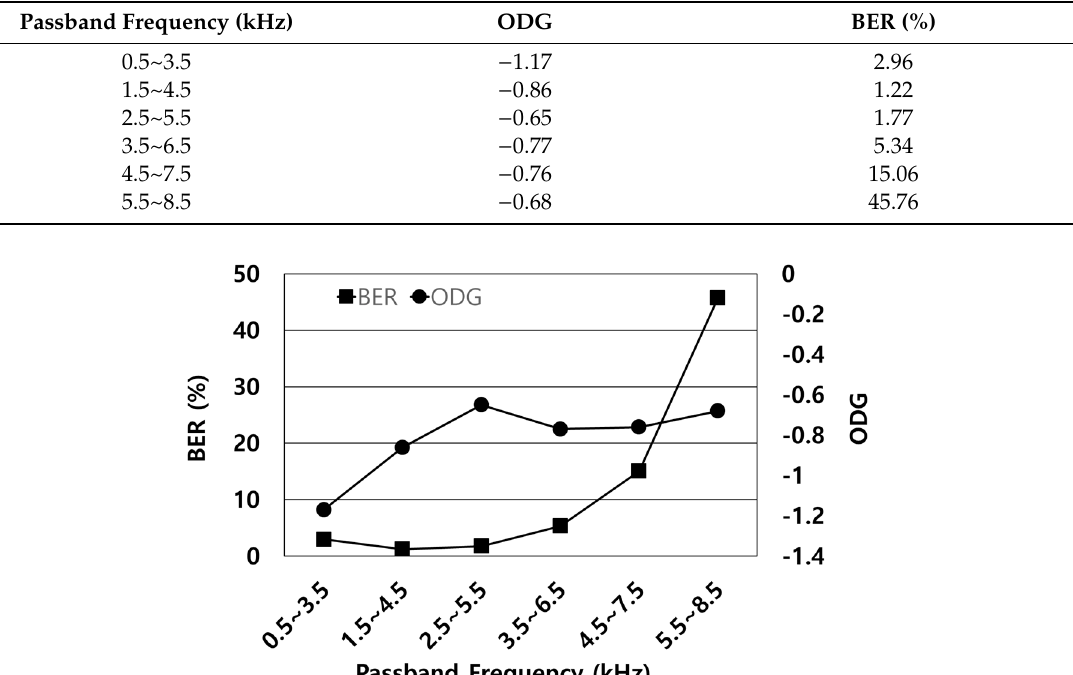
Figure 9. ODG and BER values under various data payloads. Table 3. ODG and BER values under various passband frequencies.